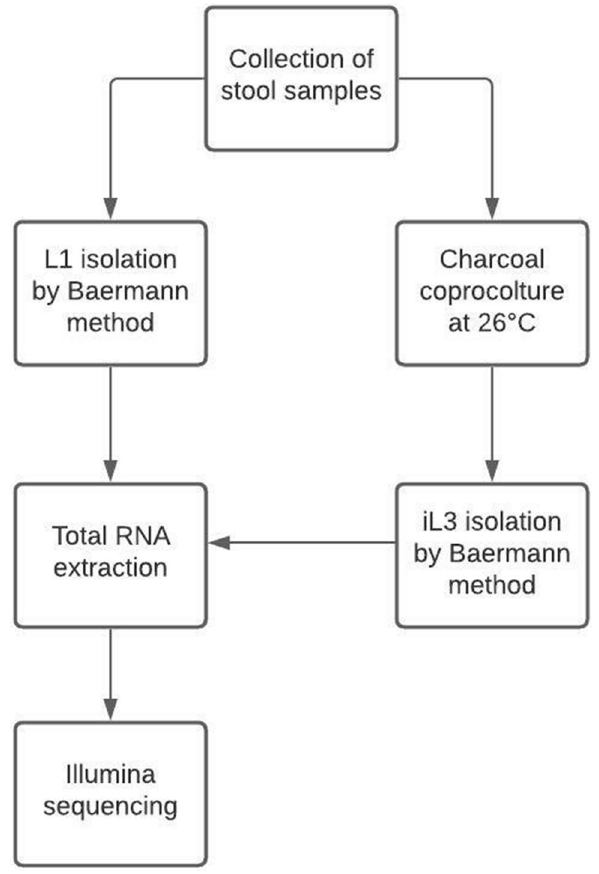
Figure 3. Flowchart of the study.